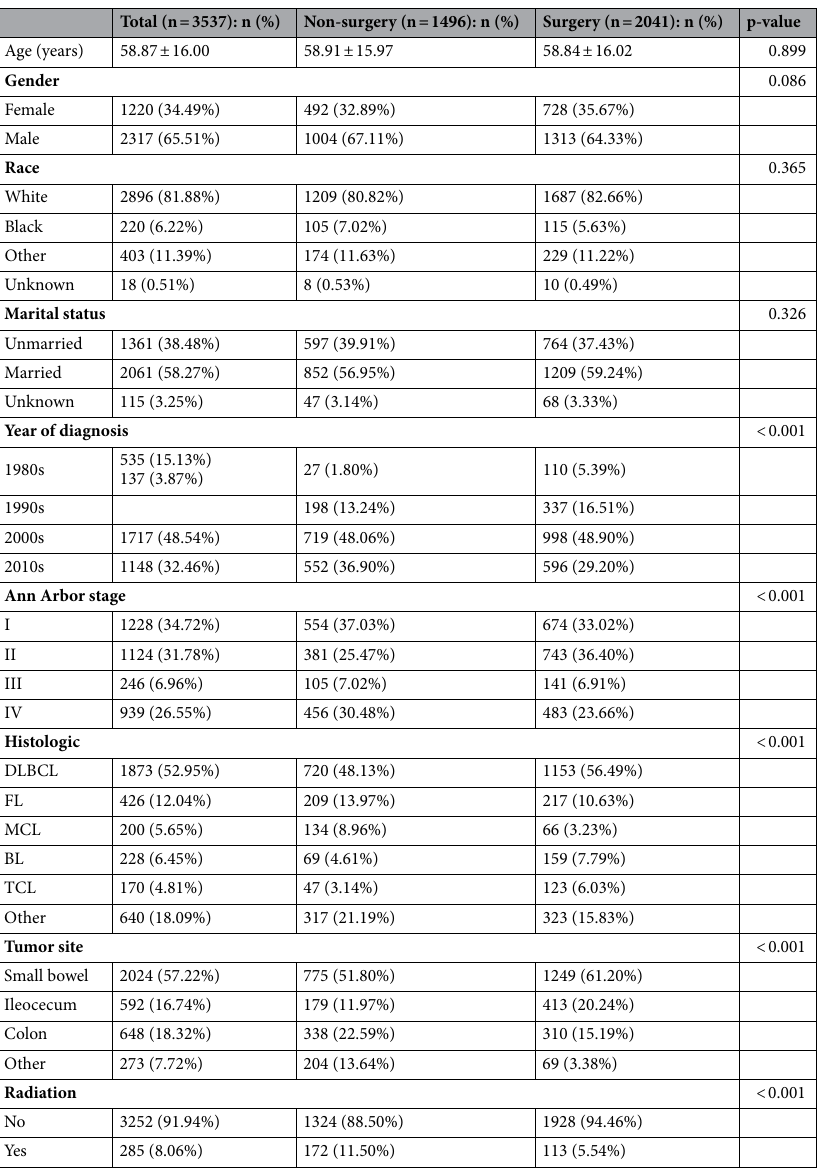
Table 1. Baseline patient demographic and clinical characteristics. DLBCL diffuse large B cell, FL follicular lymphoma, MCL Mantle cell lymphoma, BL Burkitt lymphoma, TCL T cell